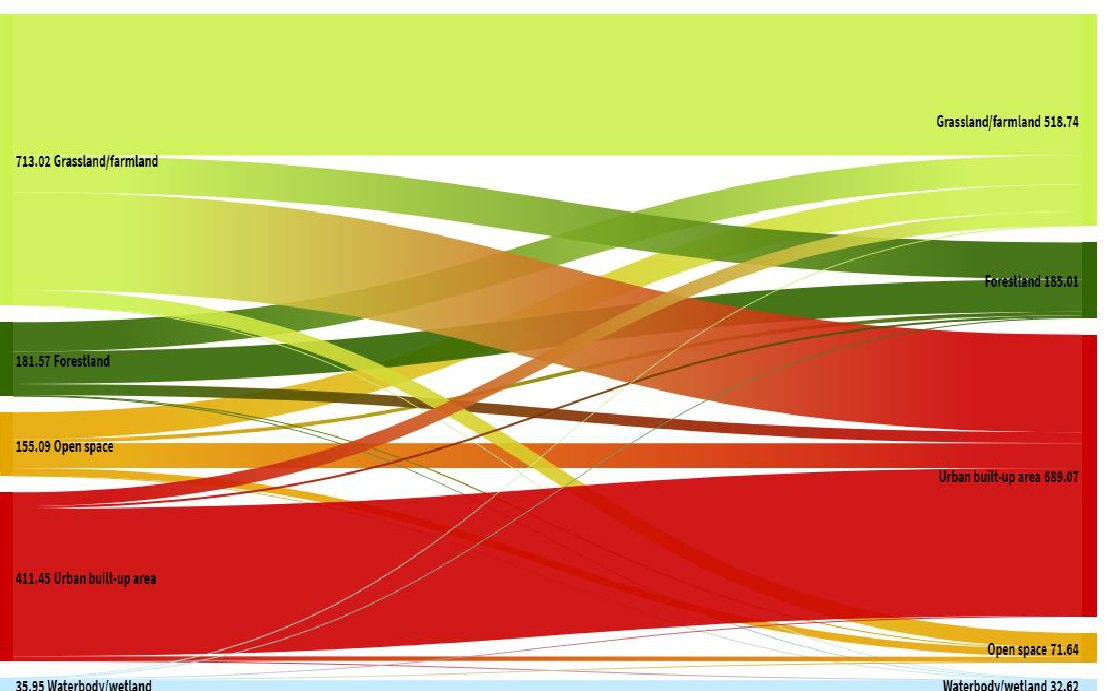
Table 2. The conversion matrix of land-use change classes from 2008 to 2017 (unit: km 2 ).